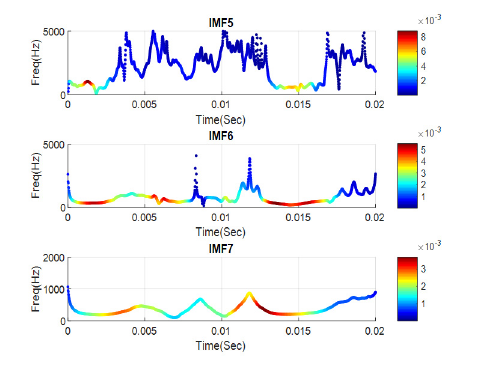
Figure 12. Captured time domain acceleration data and their frequency spectra at 180° position.